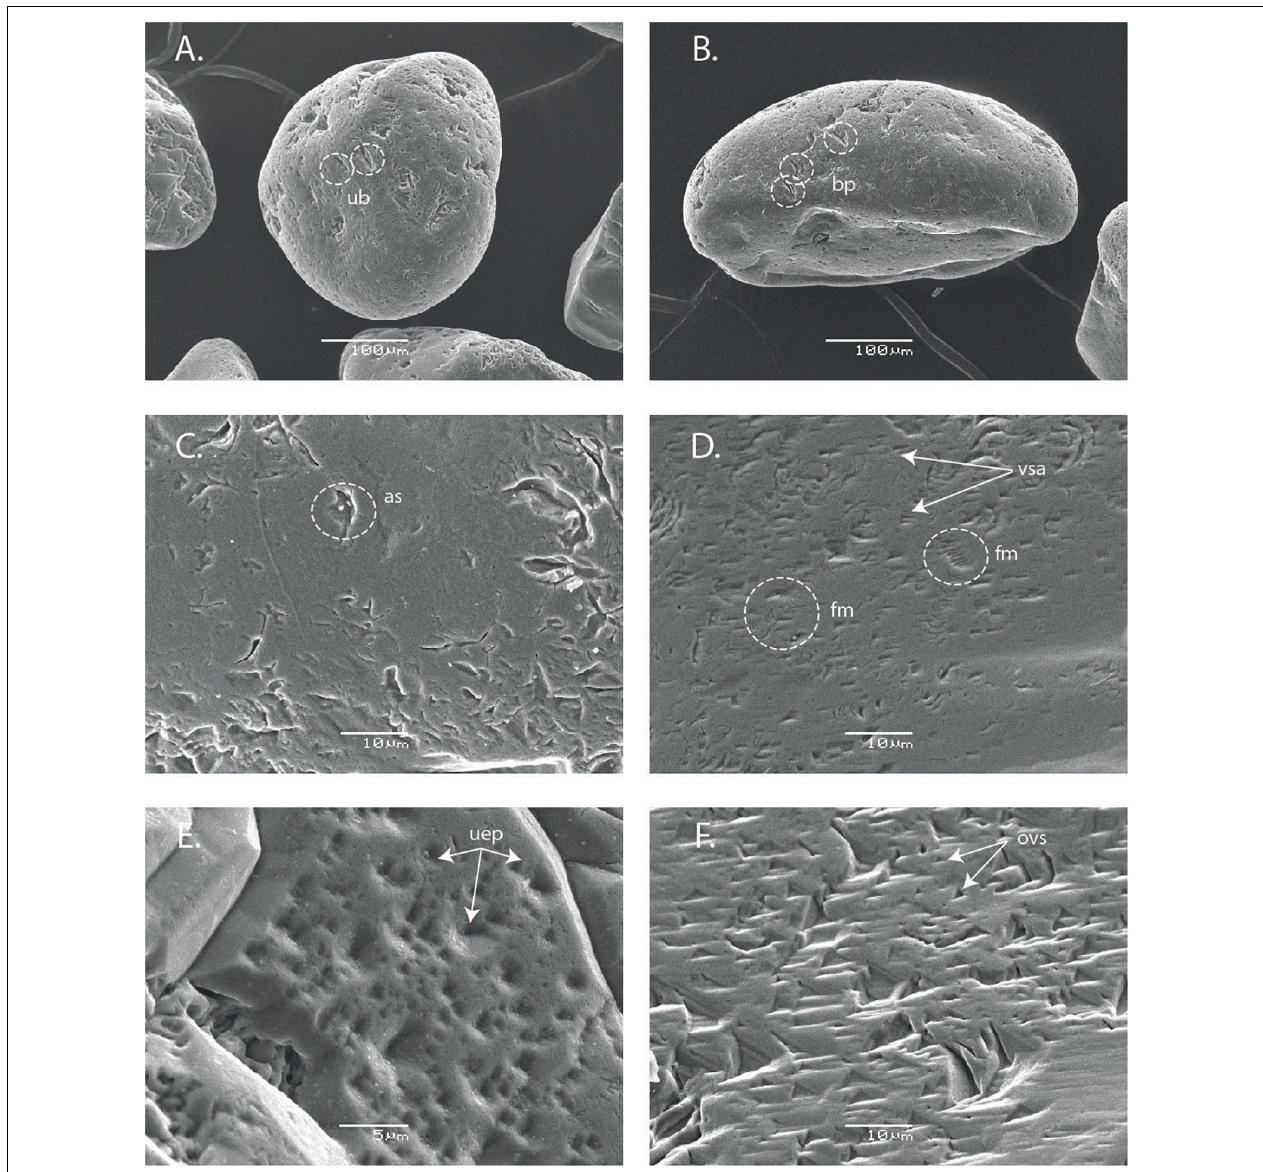
FIGURE 3 | SEM morphology of unaltered (left column) and altered (right column) sand after 10 days experiments (250 µ m, R/W = 1.8). (A) General view of a sub-rounded quartz grain of high sphericity. It exhibits used blocky breakage conchoidal patterns (ub). (B) A rounded quartz grain displaying fresh blocky conchoidal patterns (fb). (C) Detail of a plane surface showing old arc shaped impact features (as). (D) High density of V-shaped abrasion (vsa) and friction marks (fm). (E) Detail of the upper edge of the quartz grain, used etch pits are clearly visible (uep). (F) Numerous oriented V-shaped patterns